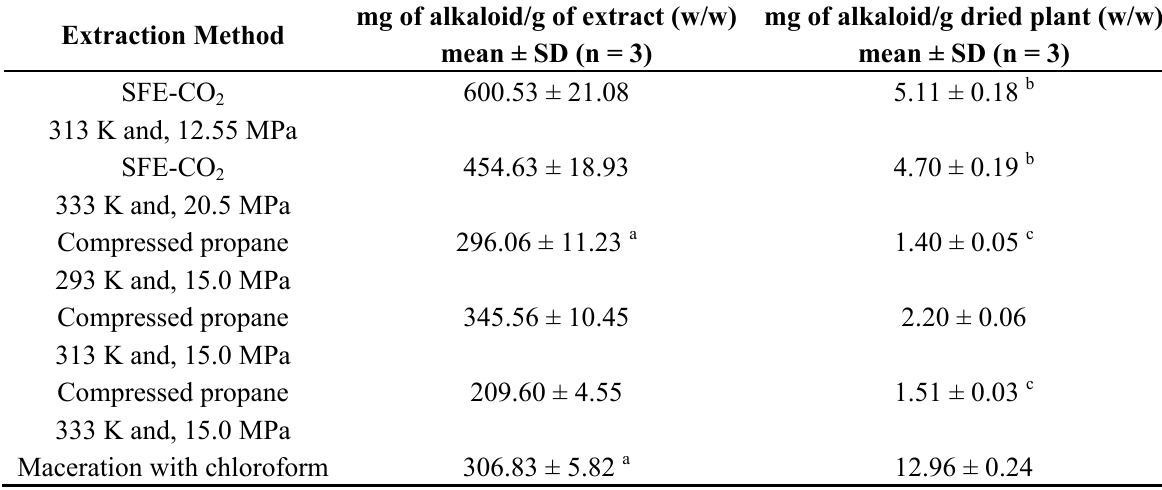
Table 2. Alkaloid content in P. amalago L. samples, expressed in mg of alkaloid/g of extract (w/w), and in mg of alkaloid/g of dried plant (w/w). Extraction Method